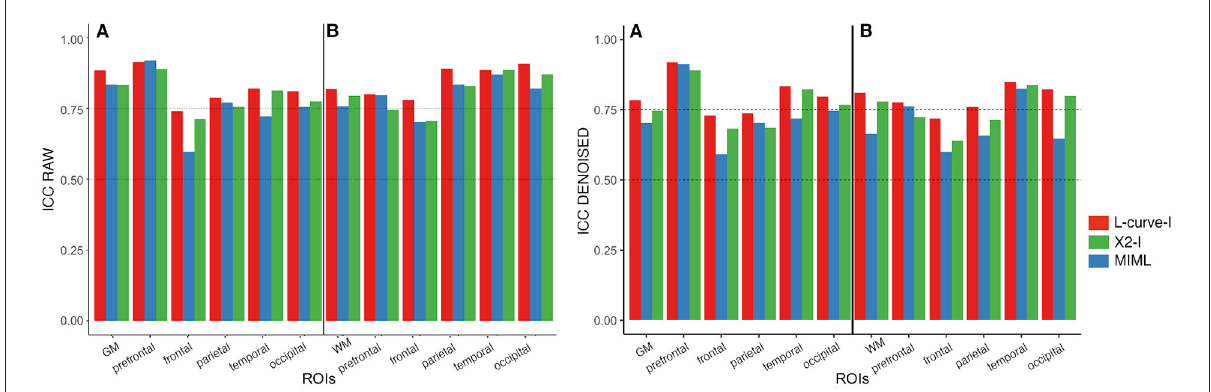
FIGURE4 Regional ICC of Mean T IE 2 for all three reconstruction methods for raw (left plot) and denoised data (right plot). Results for GM and WM are displayed in sub-panels (A,B), respectively. In each plot, the following anatomical regions are shown, from left to right: whole-brain (GM/WM), prefrontal, frontal, parietal and temporal regions. Color bars indicate different reconstruction methods: Red: L-curve − I , Green: X 2 − I , Blue: MIML.